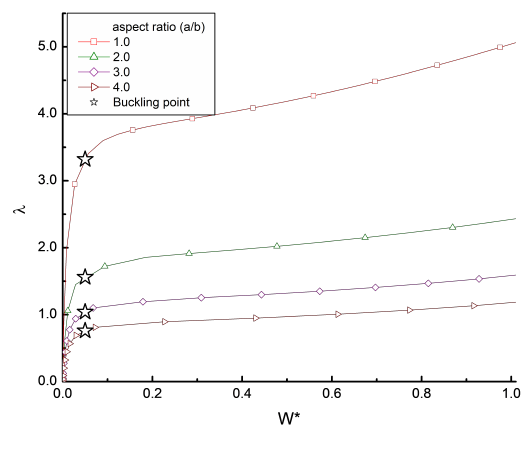
Fig. 9: Effect of aspect ratio (a/b) on the postbuckling response of SSSS A-type FG-CNT-reinforced Mg nanocomposite